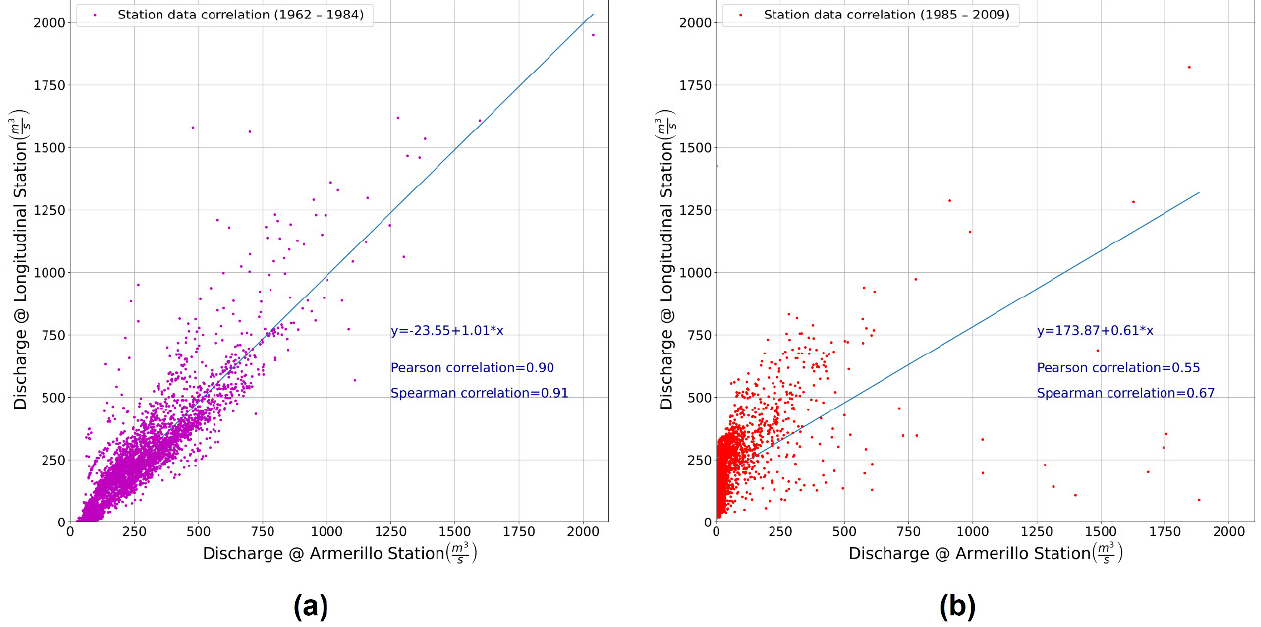
Figure 11. Mean daily flow data correlations between the Armerillo and Longitudinal stations, for ( a ) the period before and ( b ) after the dam.